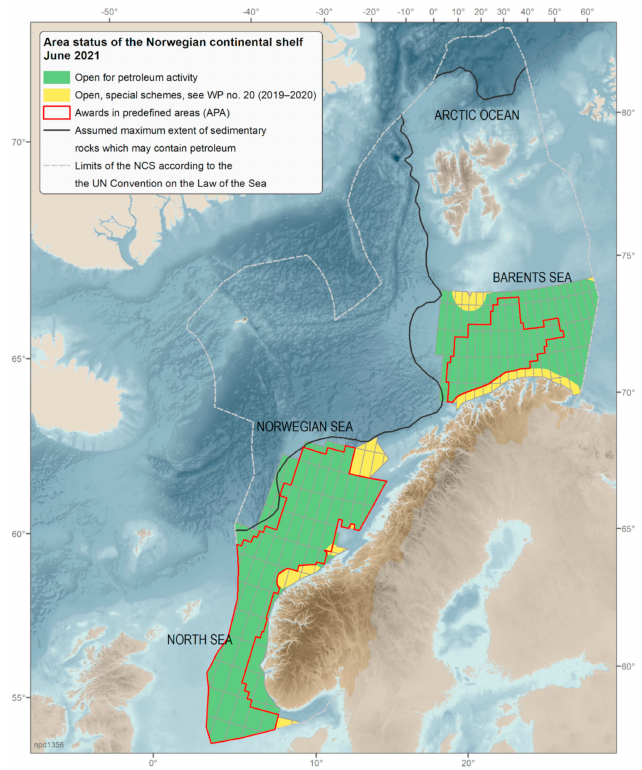
Figure 3. Map of exploration and production blocks in the Kingdom of Norway, June 2021